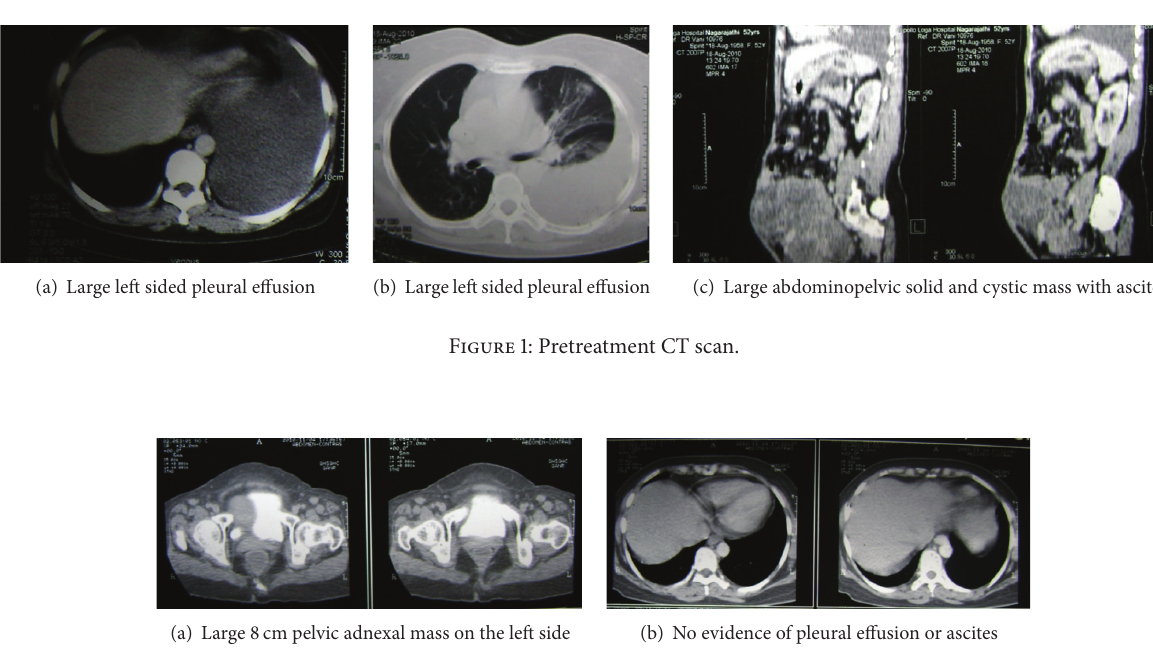
Figure 2: CT scan after 3 cycles of